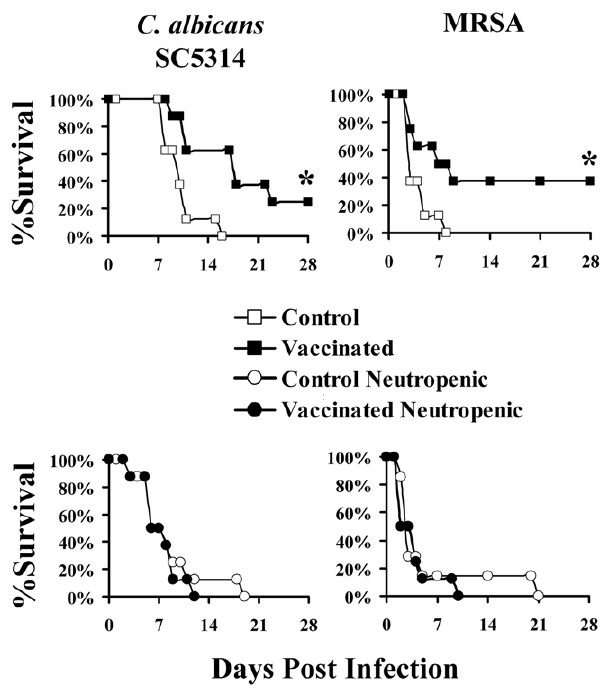
Figure 2. Chemotherapy-induced neutropenia ablated vaccine induced protection. Sixteen Balb/c mice per group were vaccinated with rAls3p-N plus AlOH 3 or AlOH 3 alone, and boosted three weeks later. Two weeks after the boost, half the mice were treated with cyclophosphamide. Two days later the mice were infected with C. albicans SC5314, 1.5 6 10 5 , C. albicans 15563, 7 6 10 5 , or MRSA LAC,